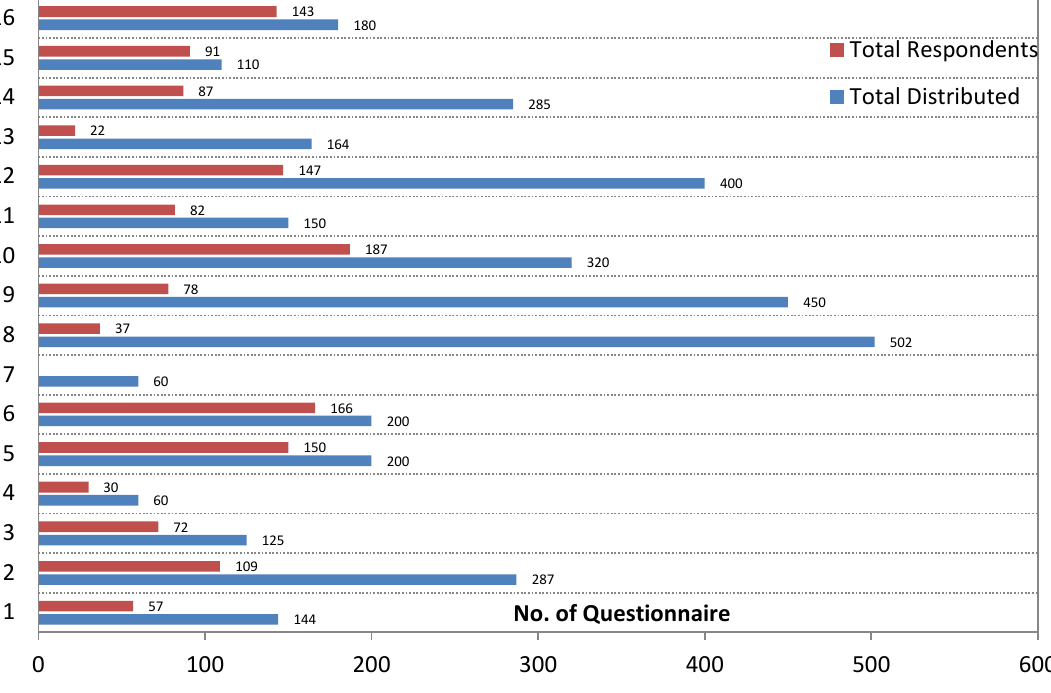
Figure 1 Total number of questionnaires distributed and response